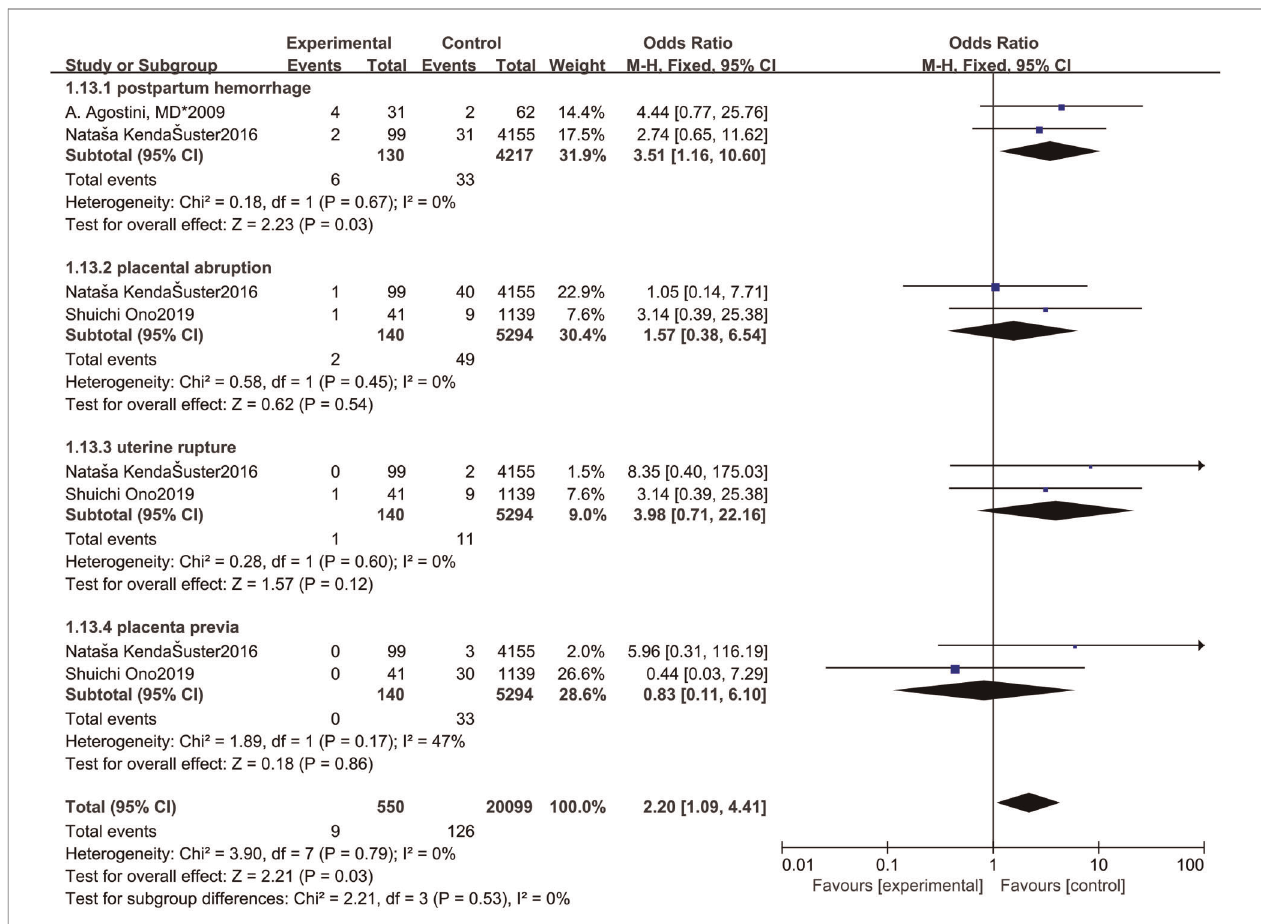
FIGURE 9 | Forest plot of other adverse obstetric outcomes for treatment with hysteroscopic resection group versus intact uterine